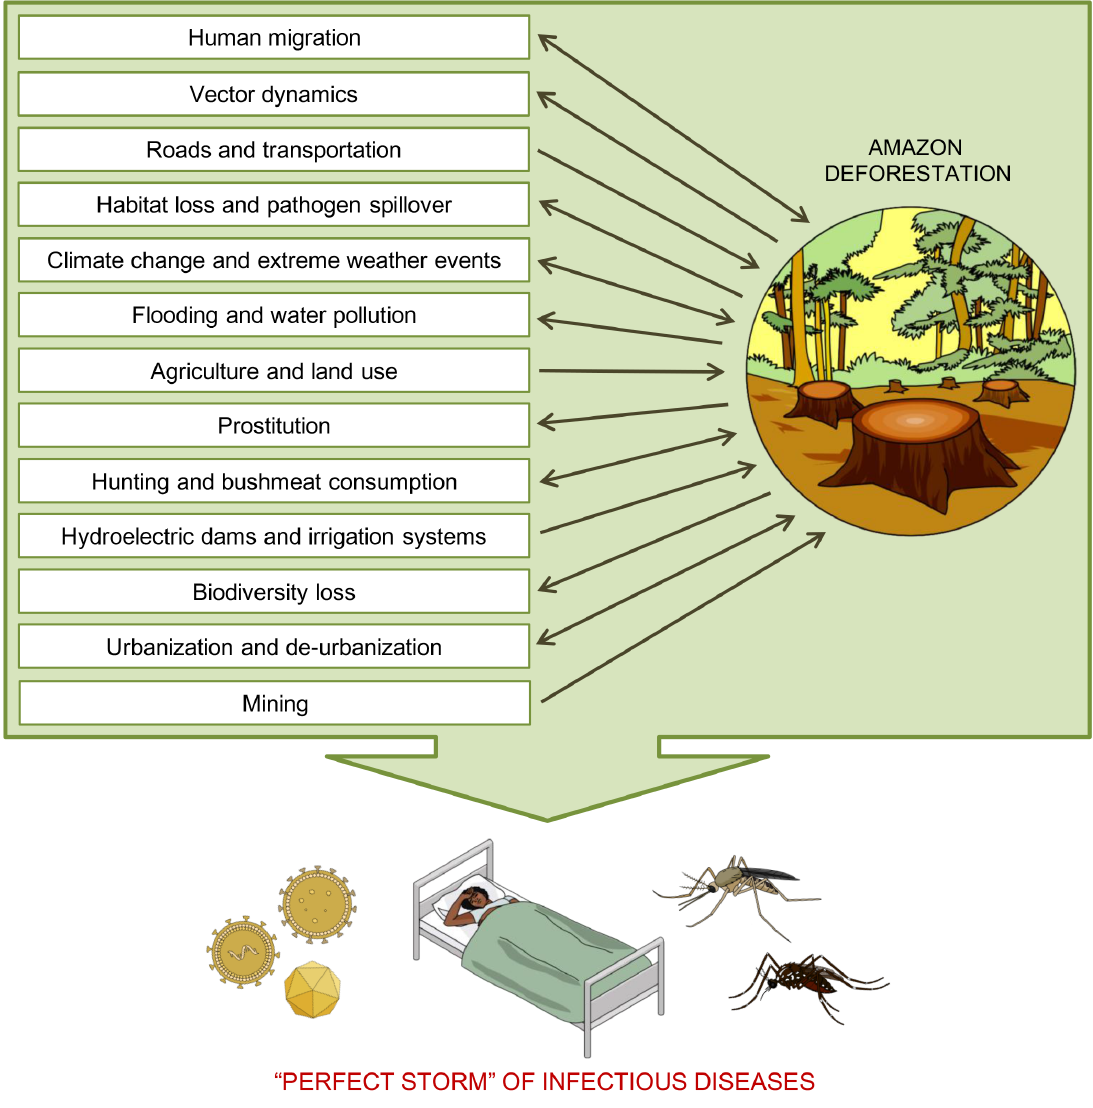
Figure 1. Problems and activities associated with Amazon deforestation and impacts on infectious diseases. The problems and activities associated with the emergence of infectious diseases can result from Amazon deforestation (e.g., floods and water pollution). In other situations, they act as promoters of deforestation (e.g., road construction and mining). Some factors are both consequences and causes of deforestation, as in the case of human migrations and urbanization, as represented by bidirectional arrows. This figure was created using Mind the Graph illustrations (available at